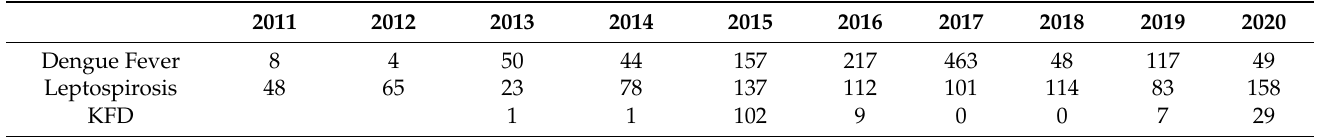
Table 3. List of confirmed cases of three selected emerging infectious diseases (EIDs) in Wayanad dis-